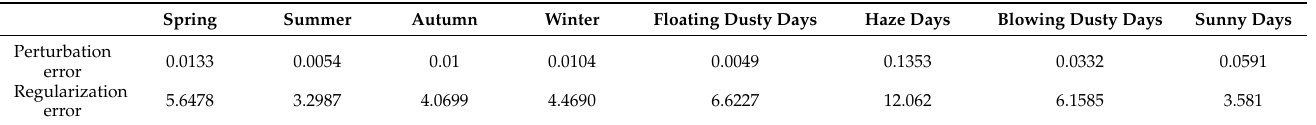
Table 2. The perturbation error and regularization error of TSVD regularization algorithm inversion under different seasons and weather conditions.